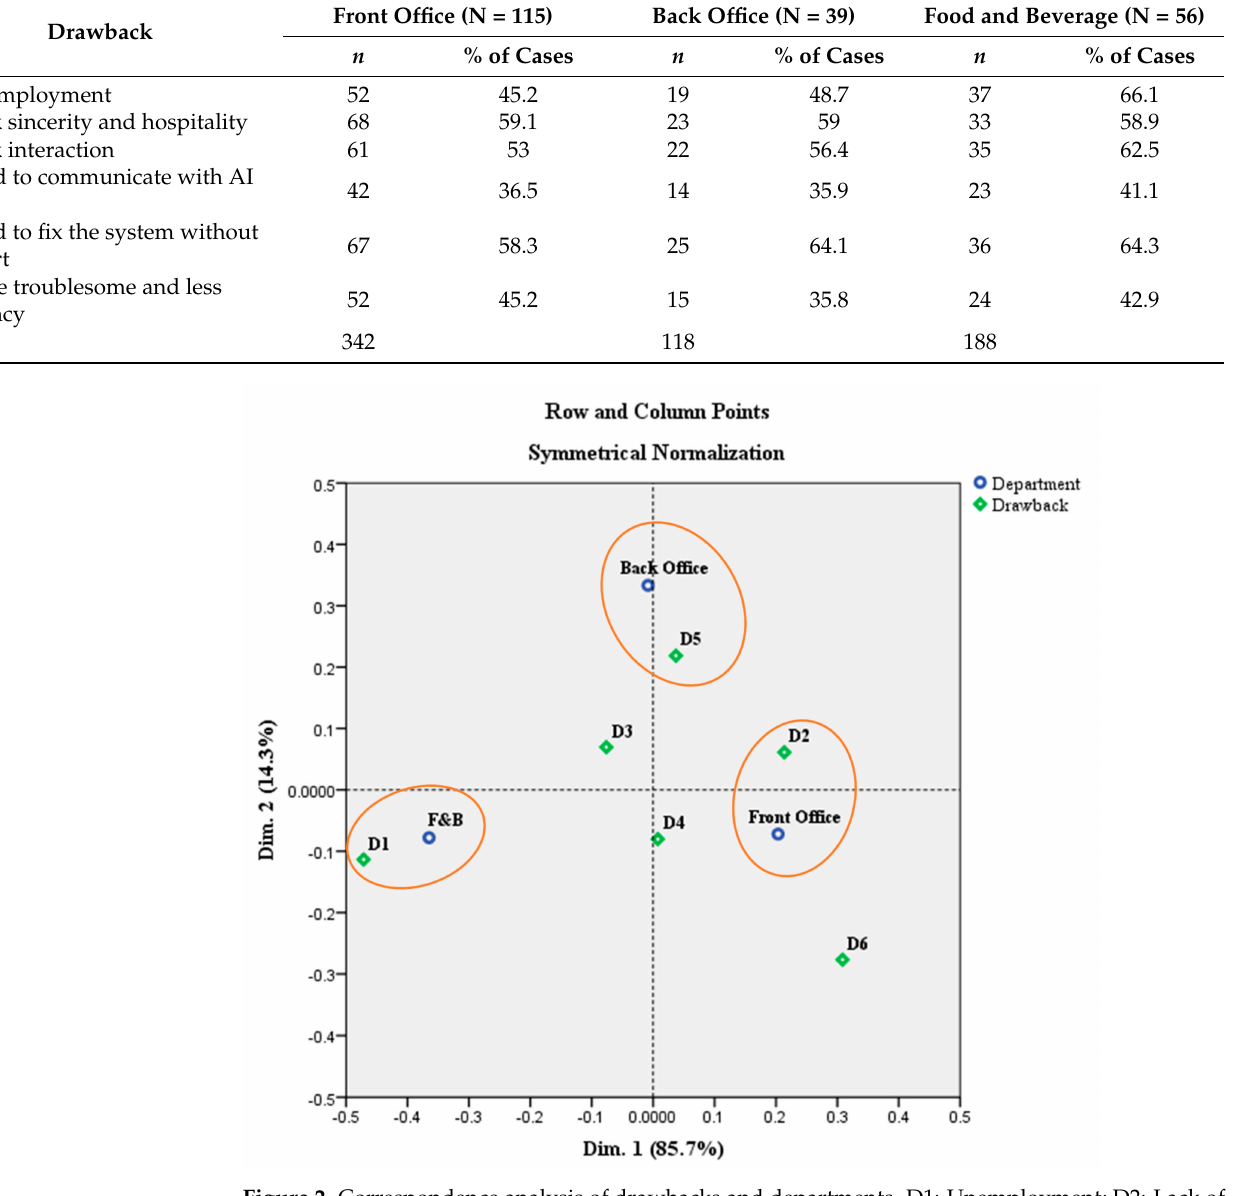
Figure 2. Correspondence analysis of drawbacks and departments. D1: Unemployment; D2: Lack of sincerity and hospitality; D3: Lack of interaction; D4: Hard to communicate with AI robots; D5: Hard to fix the system without support; D6: More troublesome and less